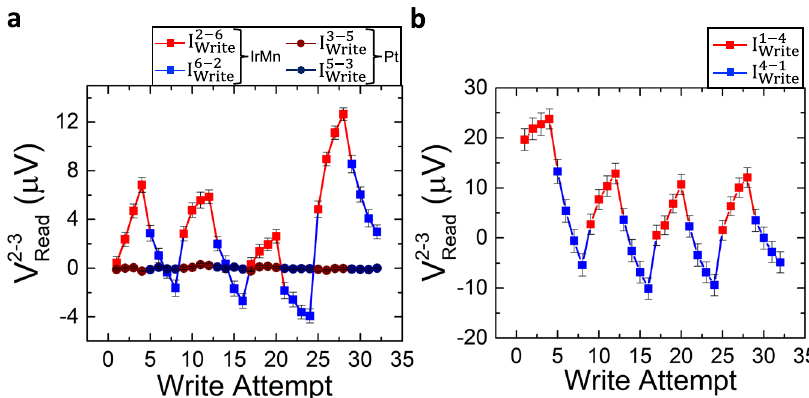
Fig. 2 Measured differential voltage ( V 2-3 Read ) for the 180° switching con fi guration with 20 mA write pulses. a The writing current is applied along the short arms of the double-cross structure. Square points refer to the case of a writing current applied in the arm with the IrMn 3 pillar (square red points from electrode 2 to 6, I 2-6 Write , and square blue points from electrode 6 to 2, I 6-2 Write ), and the circle data points correspond to the arm only with Pt (circle brown points from electrode 3 to 5, I 3-5 write , and circle dark blue points from electrode 5 to 3, I 5-3 Write ). The differential voltage of the device only shows a measurable switching signature when the current pulse is applied through the IrMn 3 pillar cross, i.e., in cases I 2-6 Write and I 6-2 Write . b 180° switching when the writing current is applied from electrode 1 to 4 ( I 1-4 write , square red points) or vice versa (square blue points). In this case, the write current pulse always passes through the section with the IrMn 3 pillar, showing a readout voltage with a similar switching behavior as the case of the write current I 2-6 write , but with larger voltage variation. Each data point corresponds to the mean value of 170 consecutive measurements and the error bar to the standard deviation. Raw data for this fi gure (prior to subtraction of the background slope) can be found in Supplementary Note